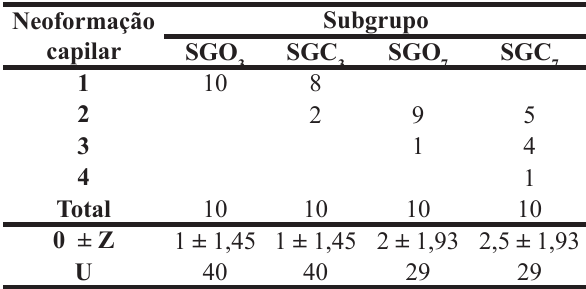
TABELA 4 – Intensidade da neoformação capilar nos animais dos subgrupos controle e Orbignya , analisada nos 3º e 7º